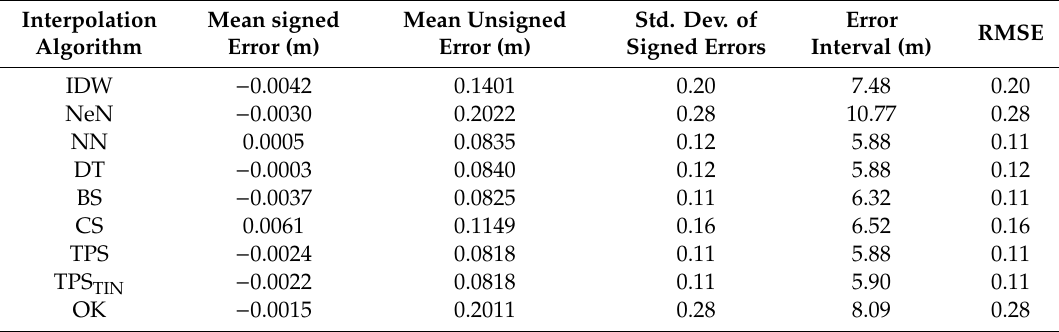
Table 3. Accuracy of interpolation algorithms at the 0.5 m spatial resolution.